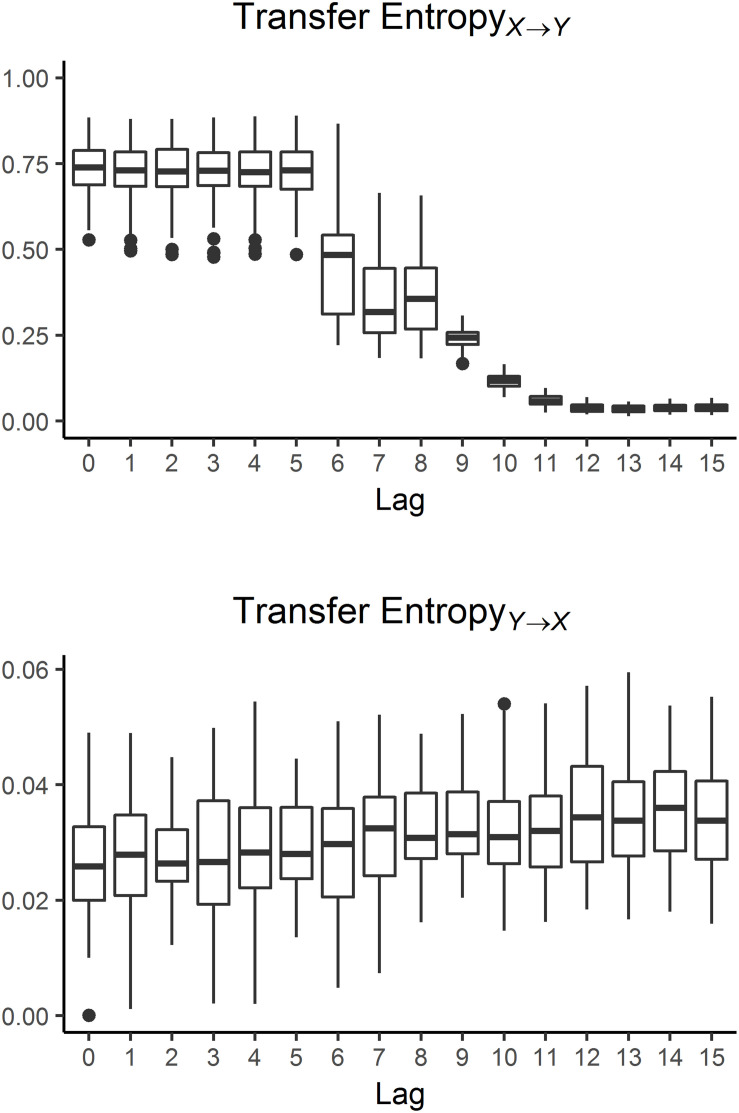
TE estimates for the directionality X→Y
(top) and Y→X
(bottom) computed on simulate dataset. TEX→Y exhibit a marked influence as lags are progressively increasing. On the contrary, no influence of lags over TEY→X is detected.